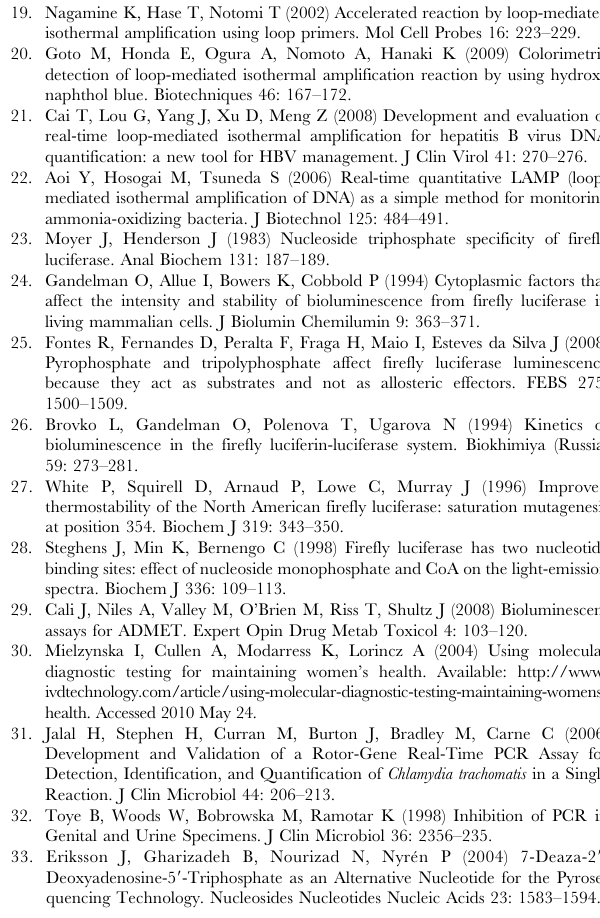
Table S1 Chlamydia strains tested for inclusivity.